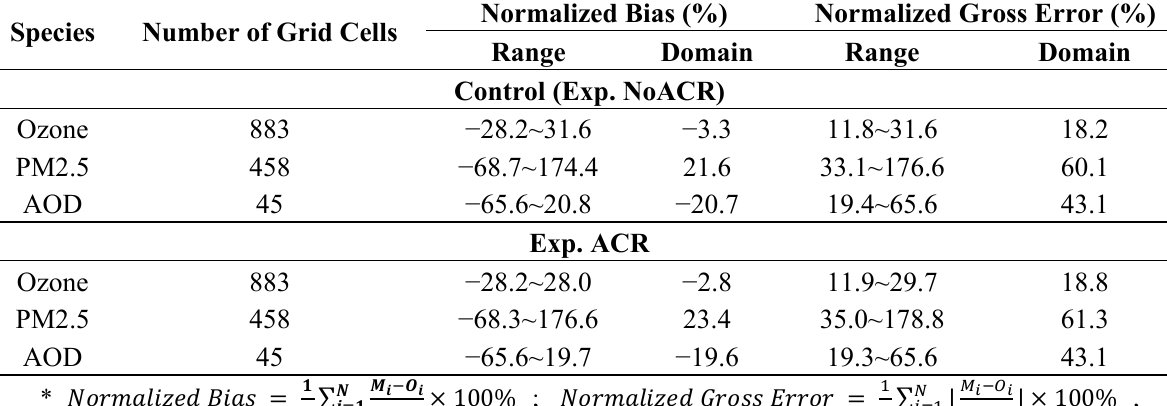
Figure 3. Spatial distribution of three-month average daily precipitations (mm) from the rain gauge measurements ( left ); and NU-WRF NoACR experiment ( right ). Table 2. Comparison of NU-WRF simulated near surface ozone/PM2.5 concentrations and AOD at 500 nm to the respective observation